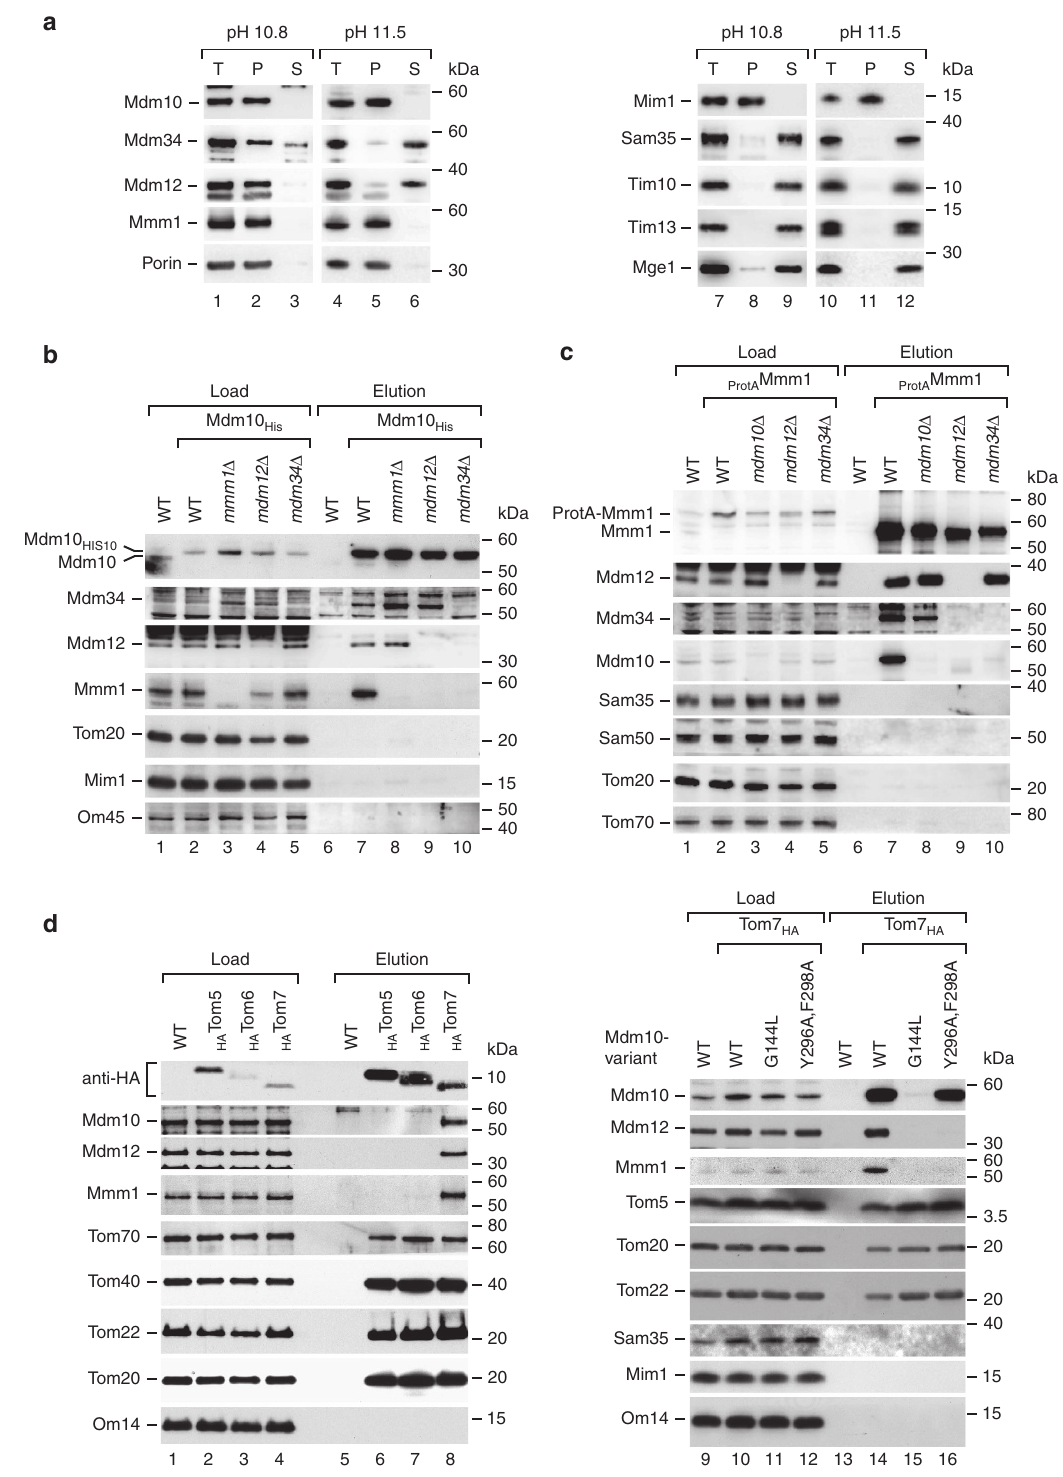
Figure 4 | Mdm10 anchors the ERMES complex in the mitochondrial outer membrane. ( a ) Mitochondria isolated from wild-type (WT) cells were incubated in 0.1M Na 2 CO 3 at pH 10.8 and 11.5. Soluble and membrane-bound proteins were separated by ultracentrifugation. Samples were analysed by SDS–polyacrylamide gel electrophoresis (SDS–PAGE) and immunodetection with the indicated antisera. Comparable amounts of the total sample (T), membrane pellet (P) and supernatant (S) were loaded. ( b ) Whole-cell extracts of WT, Mdm10 His , Mdm10 His mdm12 D , Mdm10 His mdm34 D and Mdm10 His mmm1 D cells were solubilized with digitonin and subjected to affinity purification using Ni-NTA. Samples were analysed by SDS–PAGE and immunodetection. Load 2%, elution 100%. ( c ) Whole-cell extracts of WT, ProtA Mmm1, ProtA Mmm1 mdm10 D , ProtA Mmm1 mdm12 D and ProtA Mmm1 mdm34 D cells were solubilized with digitonin and subjected to affinity purification via IgG-Sepharose. Load 2%, elution 100%. ( d ) Mitochondria isolated from WT, HA Tom5, HA Tom6 and HA Tom7 cells (left panel) or from WTand Tom7 HA cells expressing the indicated mdm10 mutant forms (right panel) were solubilized with digitonin and subjected to affinity purification using anti-HA affinity matrix. Load 4% (left panel), 2% (right panel); elution